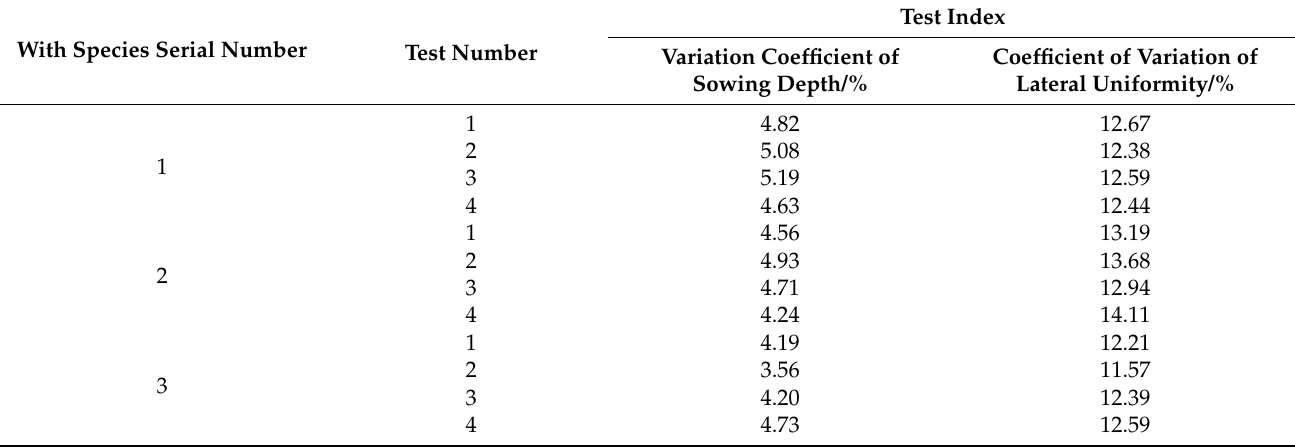
Table 6. Factors and levels of